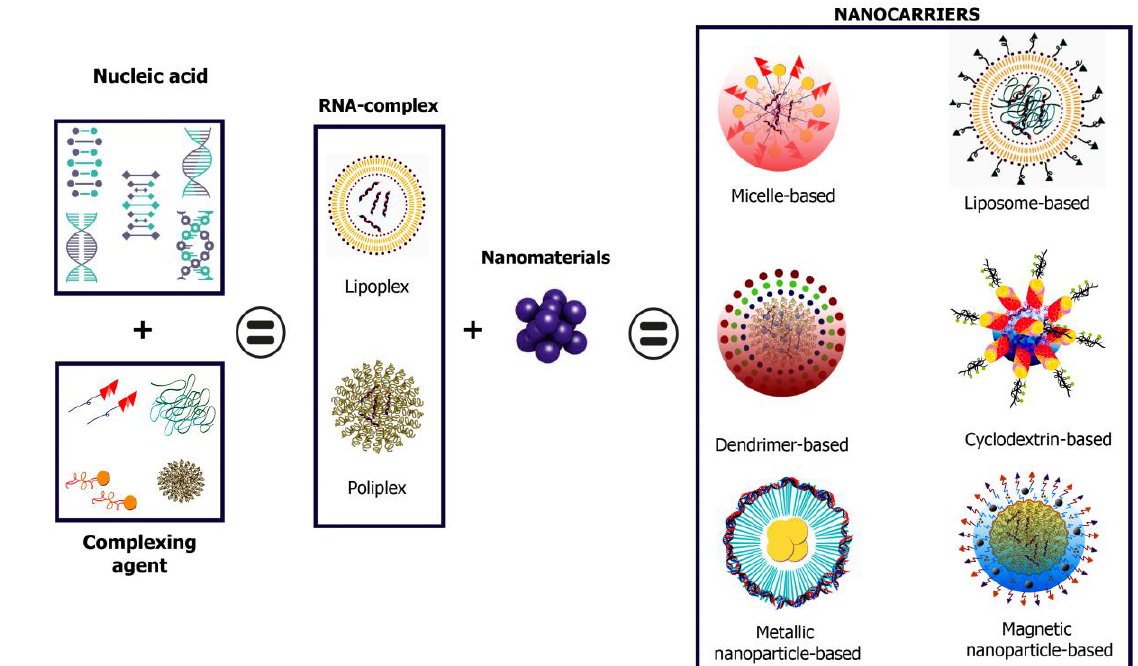
Figure 1: siRNA delivery systems can be constructed from a variety of materials with varying physico- chemical features and biological